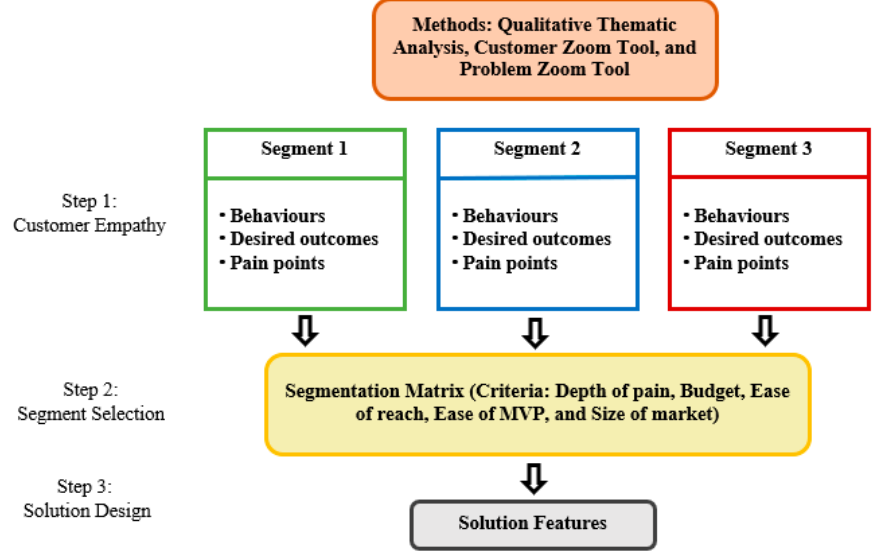
Figure 1. Theoretical Framework. Source. Figure created by authors (2022).